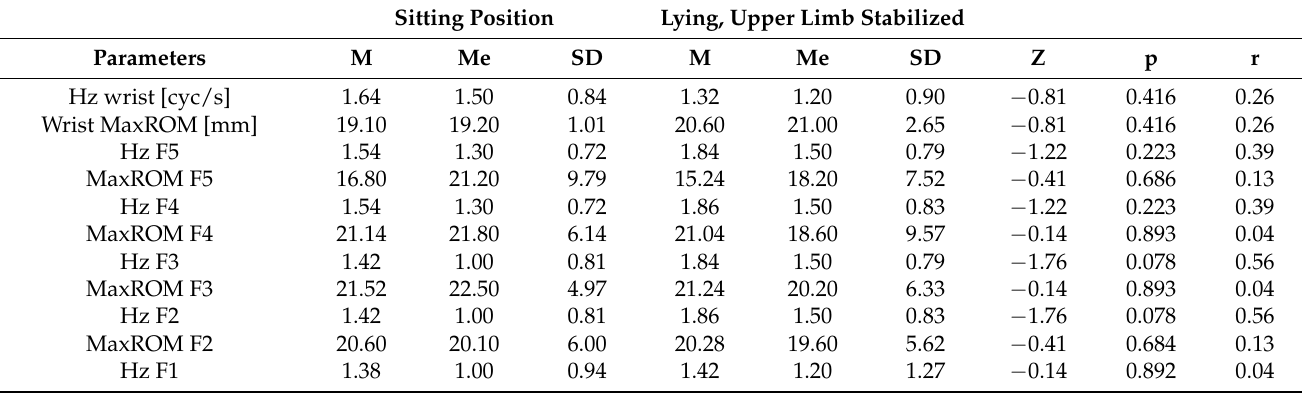
Table 6. Comparison of movement and strength parameters in sitting and lying positions with upper limb against the body in patients after cerebellar hemorrhagic stroke. Sitting Position Lying, Upper Limb